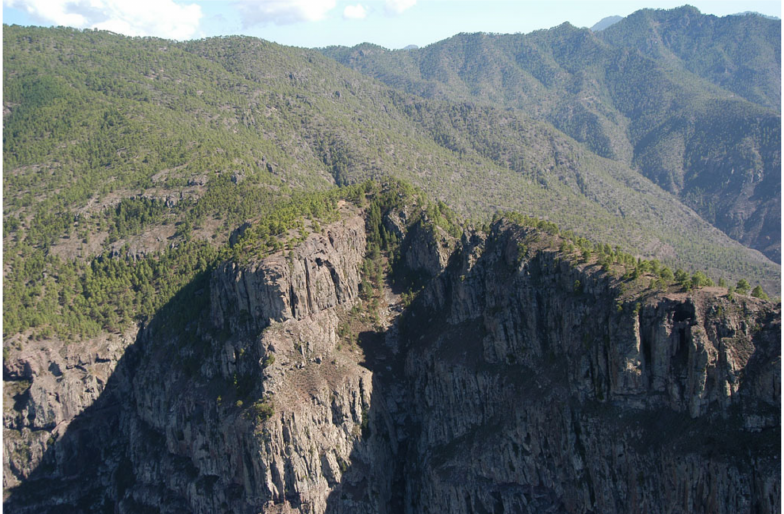
Figure 1. Tamadaba Natural Park. Source: Government of the Island of Gran Canaria.